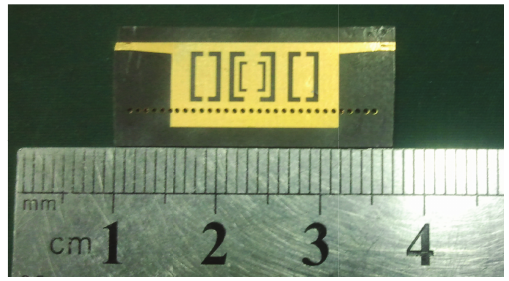
Figure 8: Photograph of fabricated HMSIW-DGS filter.